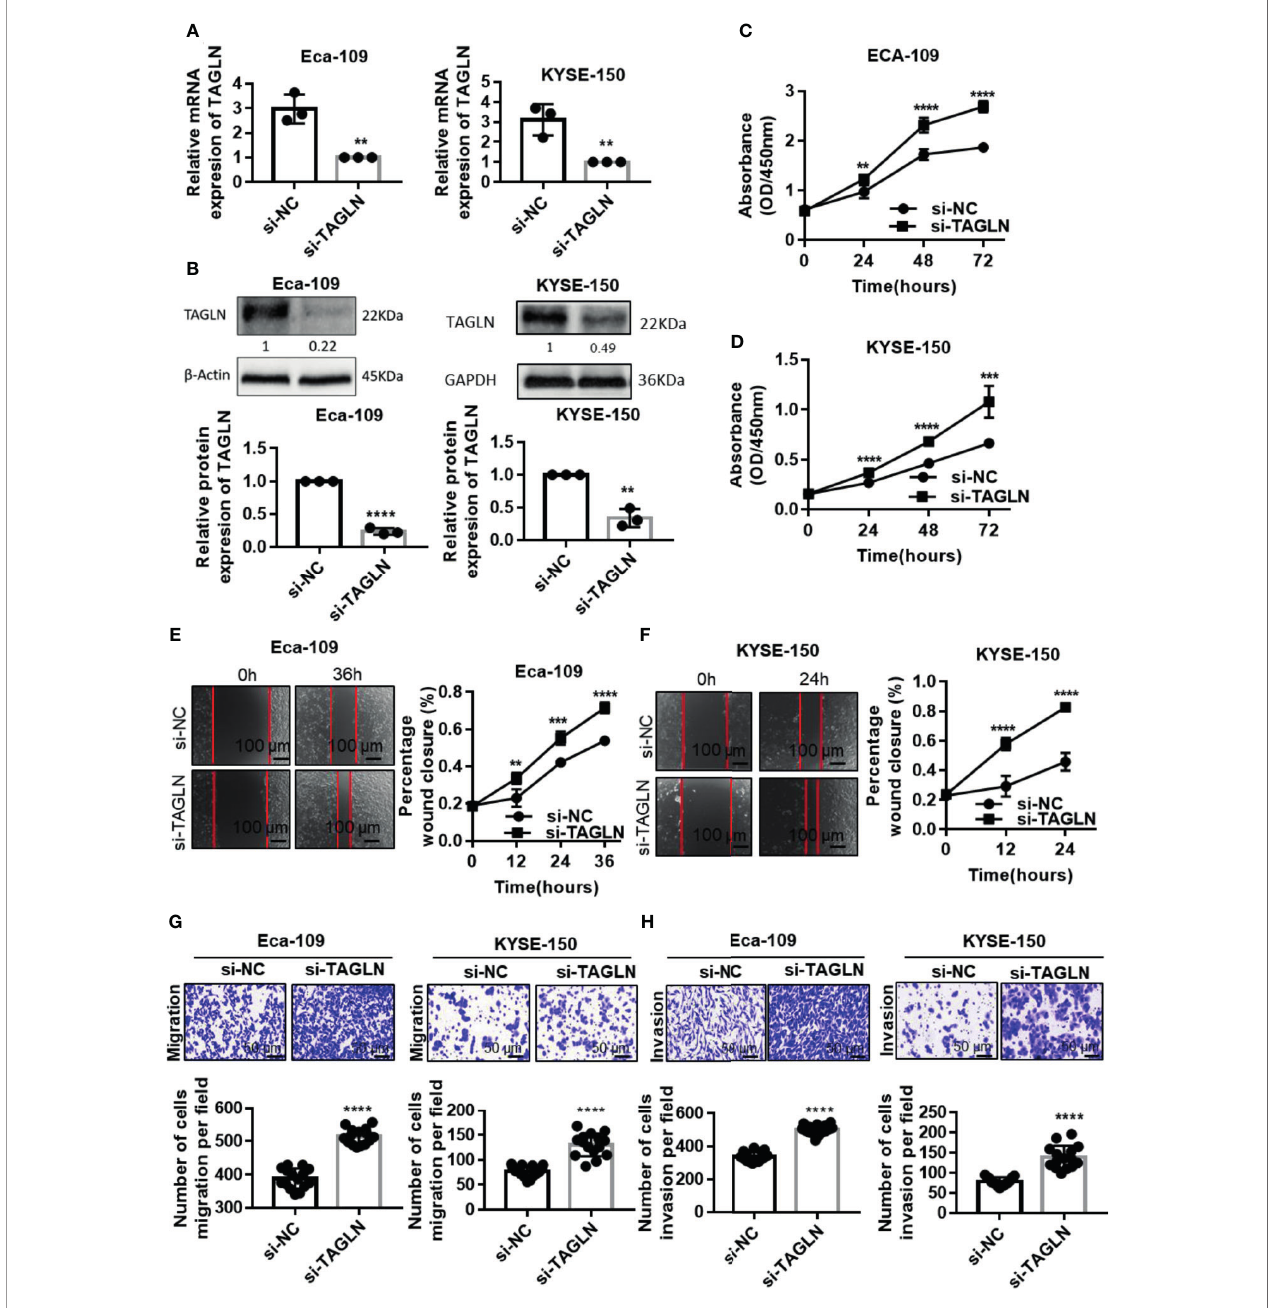
FIGURE 4 | Inhibition of Transgelin promoted the proliferation, migration and invasive abilities of esophageal squamous cell carcinomas cells in vitro . (A) Eca-109 and KYSE-150 cells transfected with siRNA to silence Transgelin, respectively. The expression of Transgelin was veri fi ed by qRT-PCR. (B) Eca-109 and KYSE-150 cells transfected with siRNA to silence Transgelin, respectively. The expression of Transgelin was veri fi ed by western blotting. GAPDH and b -Actin were used as internal controls. (C) The effects of knockdown of Transgelin on the proliferation ability was analyzed by CCK-8 kit in Eca-109 cells. (D) The effects of knockdown of Transgelin on the proliferation ability was analyzed by CCK-8 kit in KYSE-150 cells. (E) The effects of knockdown of Transgelin on the migration ability was analyzed by Scratch test in Eca-109 cells. (F) The effects of knockdown of Transgelin on the migration ability was analyzed by Scratch test in KYSE-150 cells. (G) The effects of knockdown of Transgelin on the migration ability was analyzed by transwell assay in Eca-109 and KYSE-150 cells. (H) The effects of knockdown of Transgelin on the invasion ability was analyzed by transwell assay in Eca-109 and KYSE-150 cells. The data are presented as the mean ± SEM of three independent experiments. ** P < 0.01, *** P < 0.001 and **** P < 0.0001 by two-tailed Student ’ s